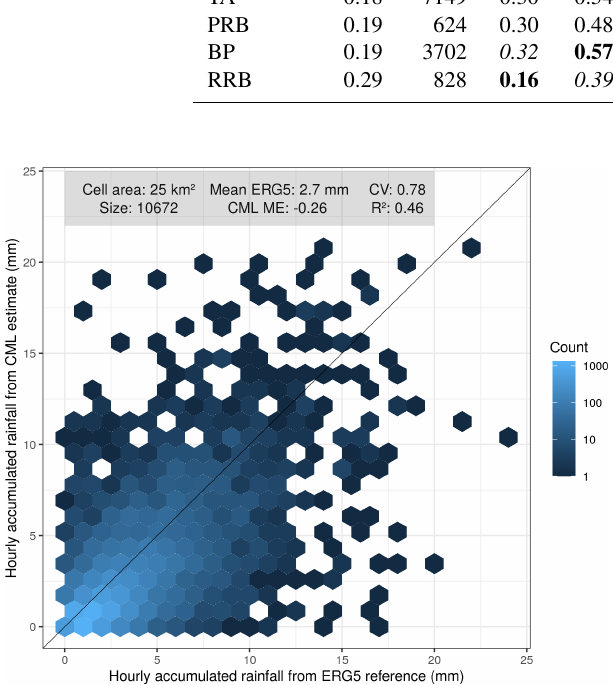
Figure 5. Hourly validation of link rainfall maps against ERG5 rain- fall maps at the grid box scale (highest resolution). Only the rainfall depths in which both CMLs and ERG5 measured > 0 . 1mm were used. The black line is the y = x